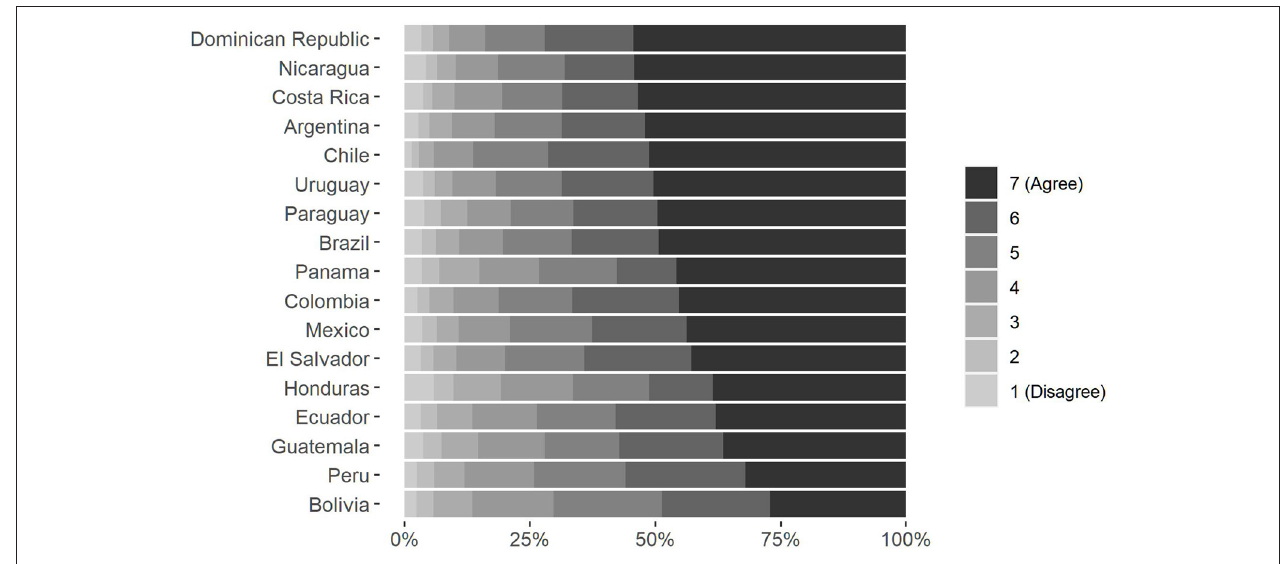
FIGURE 2 | Support for redistribution by countries. Percentage by